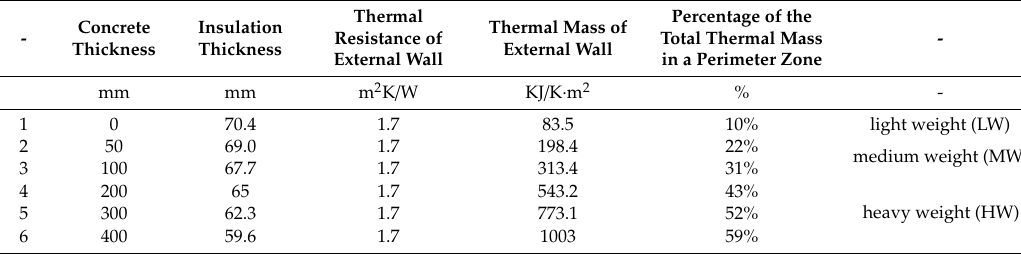
Table 1. Concrete thickness of external opaque wall and the thermal mass in a perimeter zone on one standard floor in the o ffi ce